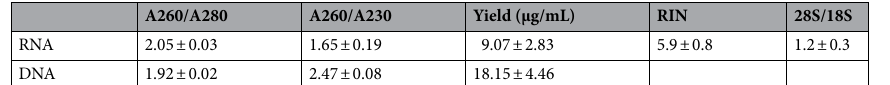
Table 3. Yield and quality of RNA and DNA extracted from peripheral whole blood samples after long-term storage. Data are shown as mean ± standard deviation (n = 30). A 260/280 absorbance ratio at 260 and 280 nm, A 260/230 absorbance ratio at 260 and 230 nm, RIN RNA integrity number, 28S/18S 28S-to-18S rRNA